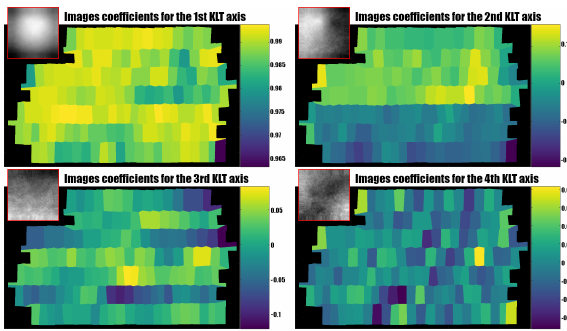
Figure 8. Six first eigen images from the KLT performed on the extrapolated images.